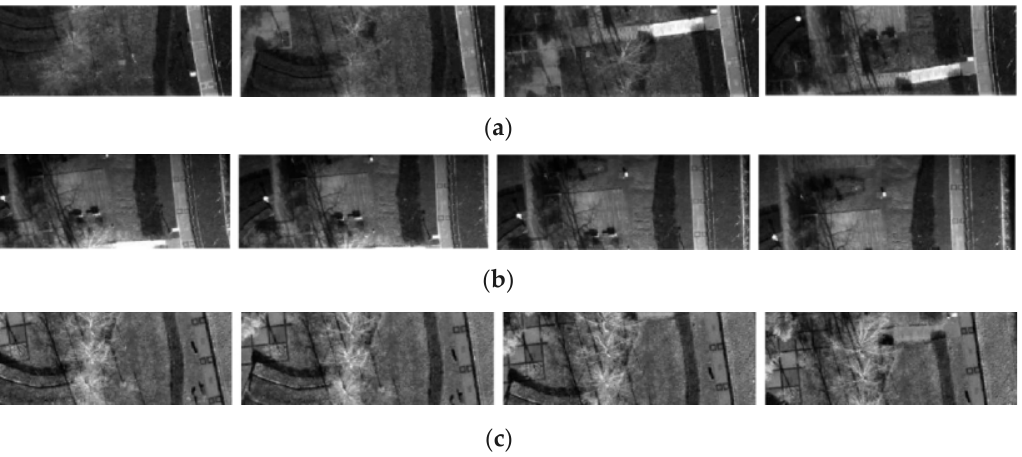
Figure 5. BGNIR multispectral aerial dataset images. ( a ) Blue spectrum images (2160 × 750 pixels); ( b ) Green spectrum images (2160 × 940 pixels); ( c ) Near infrared spectrum images (2160 × 796 pixels).